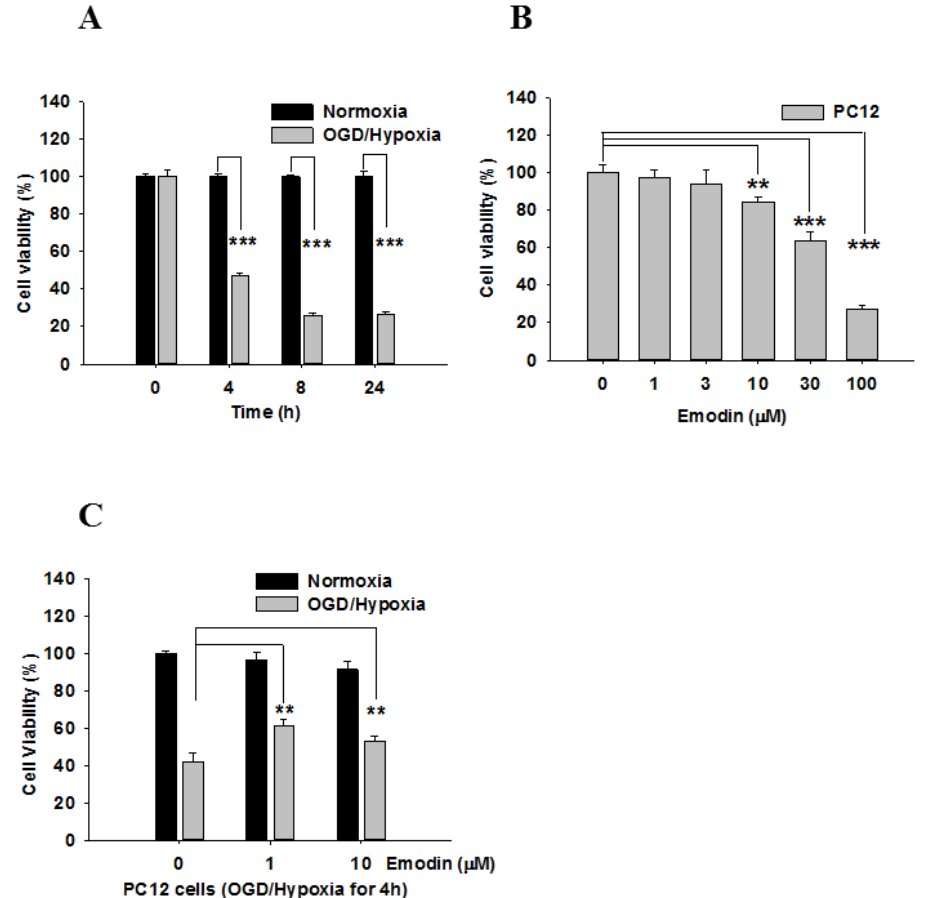
Figure 1. Emodin suppresses OGD/hypoxia-induced cell death in PC12 cells: Cell viability was determined by 3-(4,5-dimethylthiazol-2-yl)-2,5-diphenyltetrazolium bromide (MTT) assay. ( A ) Comparison of cell viability between normoxia and OGD-hypoxia at different time points. ( B ) Cell viability with different doses of Emodin. ( C ) The protective effect of Emodin under OGD/hypoxia. Data represent SEMs of three independent experiments. ** p < 0.01, *** p < 0.001 using Student’s t -test.